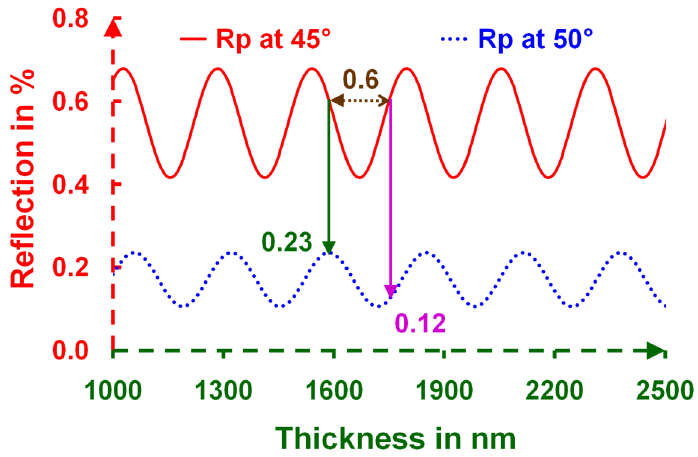
Figure 11. Reflection in p-polarization for two angles of incidence (45° and 50°) at 633 nm of a layer with a refractive index of 1.421 deposited on a substrate with a refractive index of 1.459. Thus, the local thicknesses were determined with both measurements at two different angles of incidence. Figure 12 gives an example of a comparison between the R p determined experimentally and the one calculated theoretically (t = 1935 nm) for a given thickness. The green and blue curves were computed for thicknesses other than the black ones, and only the black curve fit the experimental R p .